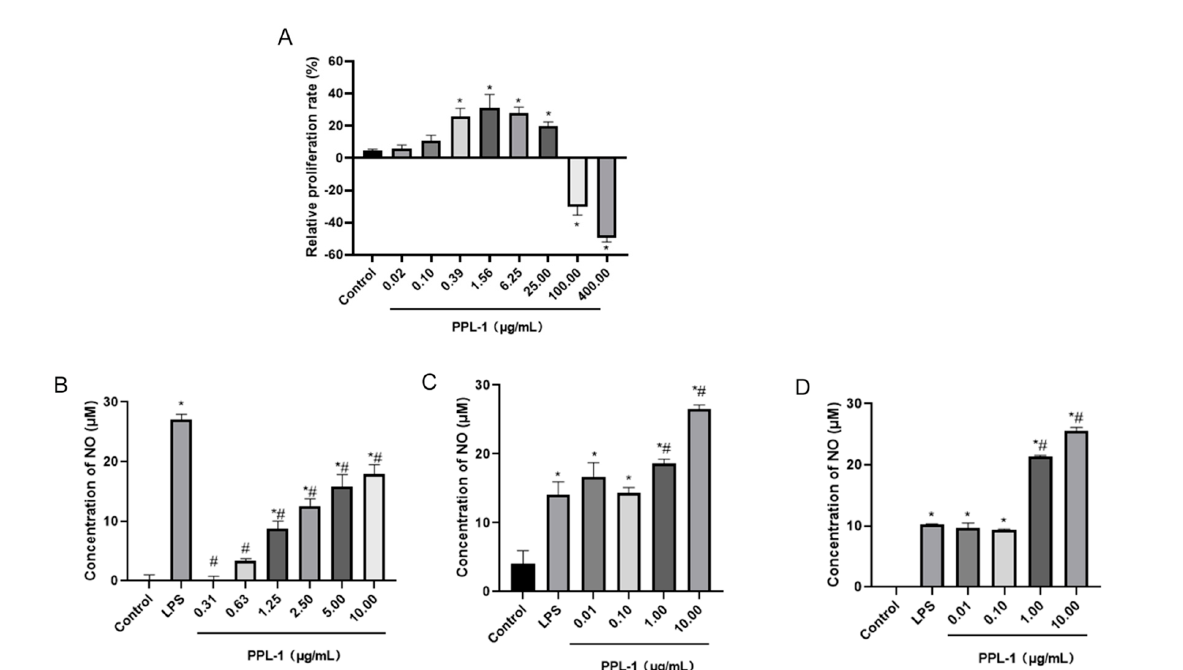
Figure 6. Effects of PPL-1 on the proliferation of RAW264.7 macrophages ( A ). ( B – D ) NO production secretion of RAW264.7 macrophages: ( B ) cells were treated with PPL-1 (0.01–10 µg/mL) and LPS (1.2 µg/mL) as the positive control group; ( C ) cells were treated with PPL-1 (0.01–10 µg/mL) after LPS (1.2 µg/mL) induction; ( D ) cells were induced by LPS (1.2 µg/mL) after being treated with PPL-1 (0.01–10 µg/mL). * p < 0.05 vs. the control group; # p < 0.05 vs. the LPS group (positive control group).